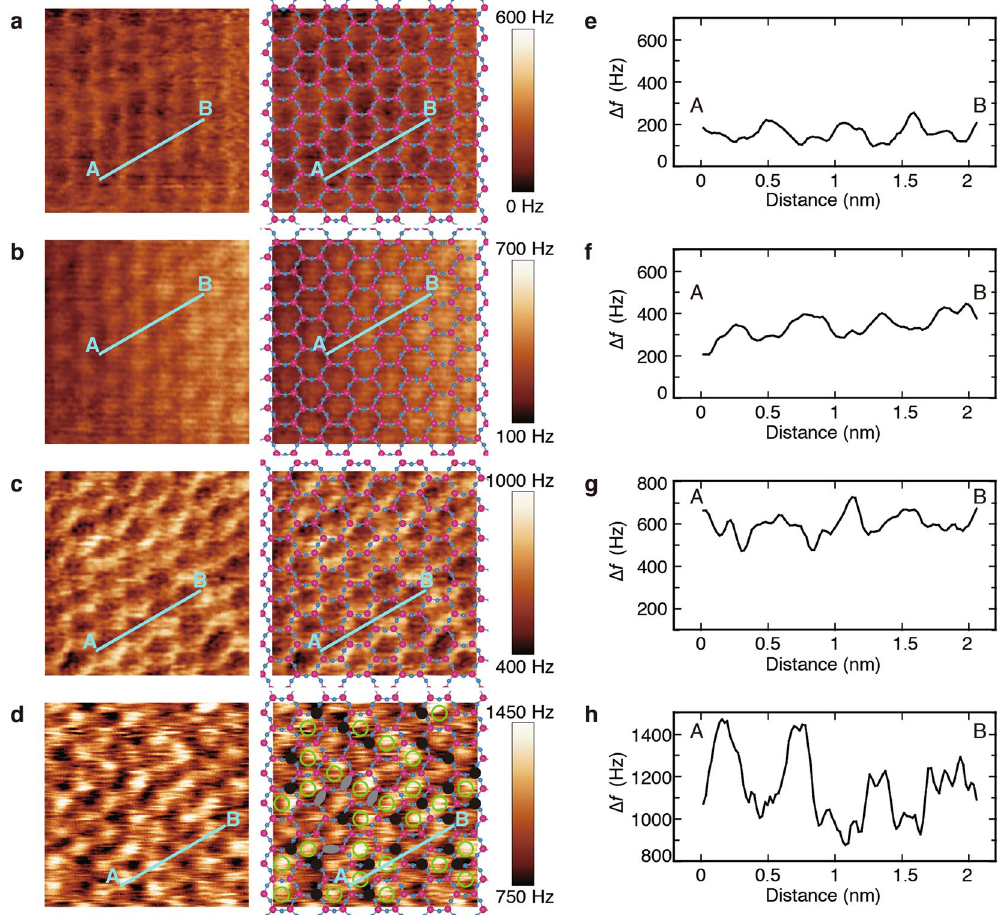
Figure 3. FM-AFM ( ∆ f ) images on muscovite surface covered with a thin water film. FM-AFM imaging was conducted in quasi-constant-height mode under weak feedback operation with increasing feedback targets for < ∆ f > of ( a ) 313 Hz, ( b ) 373 Hz, ( c ) 657 Hz, and ( d ) 1044 Hz. The brighter contrast, showing increases in ∆ f from the averaged target value of ∆ f , means stronger repulsive force. To highlight the honeycomb structure, in the images on the right, the structural model of the top plane of cleaved muscovite (001) without K atoms is superimposed on the ∆ f images on the left. Therein, O atoms and Si atoms are shown in blue and pink, respectively. In addition, the contrast features found in d are marked on the right panel: the remarkably bright dots at the ditrigonal cavity centres are denoted by open green circles: the dark spots on the Si sites of the hexagonal network by solid black circles; the elongated dark spots by grey ovals. The scan size was 3.5 nm × 3.5 nm. The resonant frequency, spring constant, and oscillation amplitude of the cantilever were 311 kHz, 37 N/m, and 0.5 nm, respectively. The scanning time was 10 sec per image. ( e–h ) ∆ f cross-sectional profiles along the line between points A and B in a–d , respectively. The profiles are parallel to the [110] direction on the muscovite surface. The lines cross over the O atoms and four cavities of the hexagonal